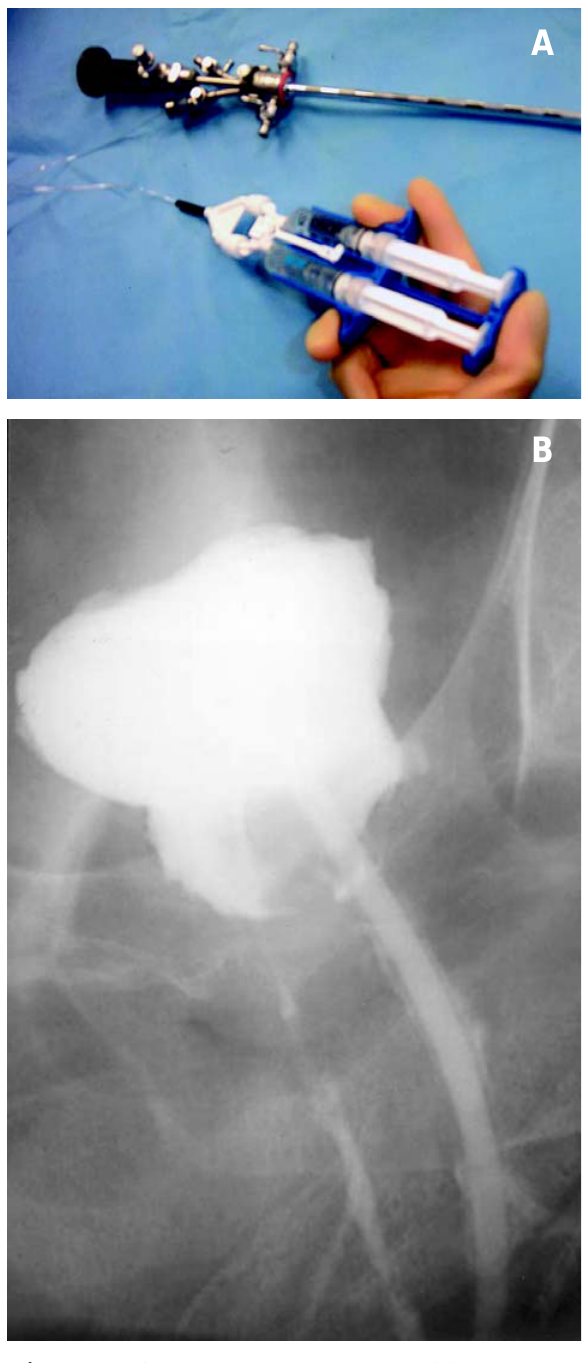
Figure 6 – A) Cystoscopic injection via dual lumen catheter with “Y” adapter is one of several available devices for applica- tion of fibrin sealant. B) In this case, sealant was delivered cystoscopically to close a urethrocutaneous fistula after endo- scopic